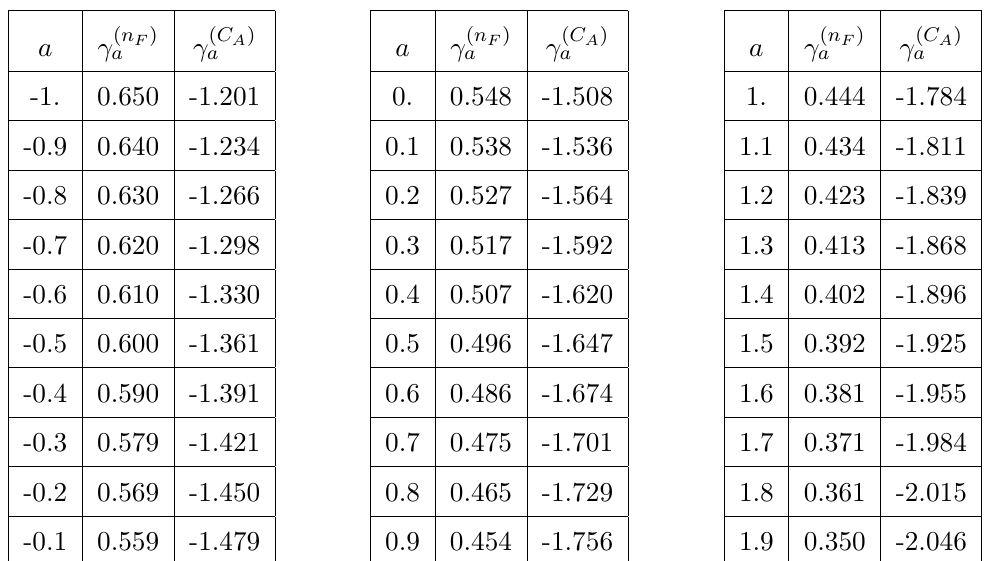
the numerical uncertainty is at a